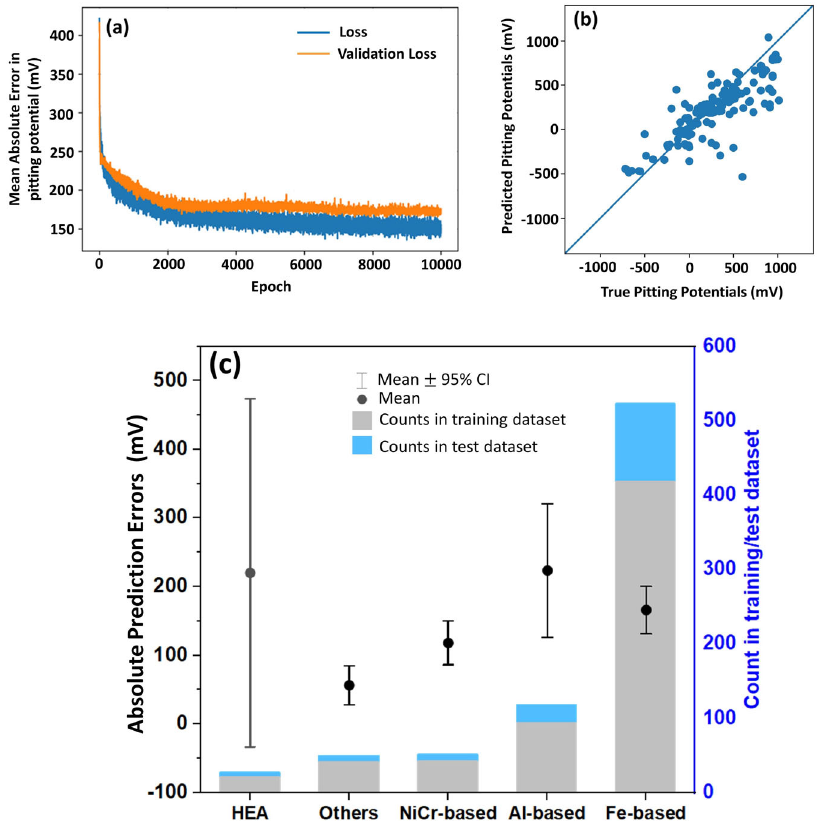
Fig. 1 Results of deep neural network training. a Mean absolute error in pitting potential of network predictions on the training and testing datasets (termed as loss and validation loss respectively) in course of training history. b Plot of the DNN predictions over the test dataset after training. c Absolute prediction errors of pitting potential (both the mean and distribution in the form of 95% con fi dence limits) from the trained DNN model within each alloy class are plotted in black along the axis on the left. The statistical representation of each alloy class within the training and test dataset is represented by the bar chart in blue along the axis on the